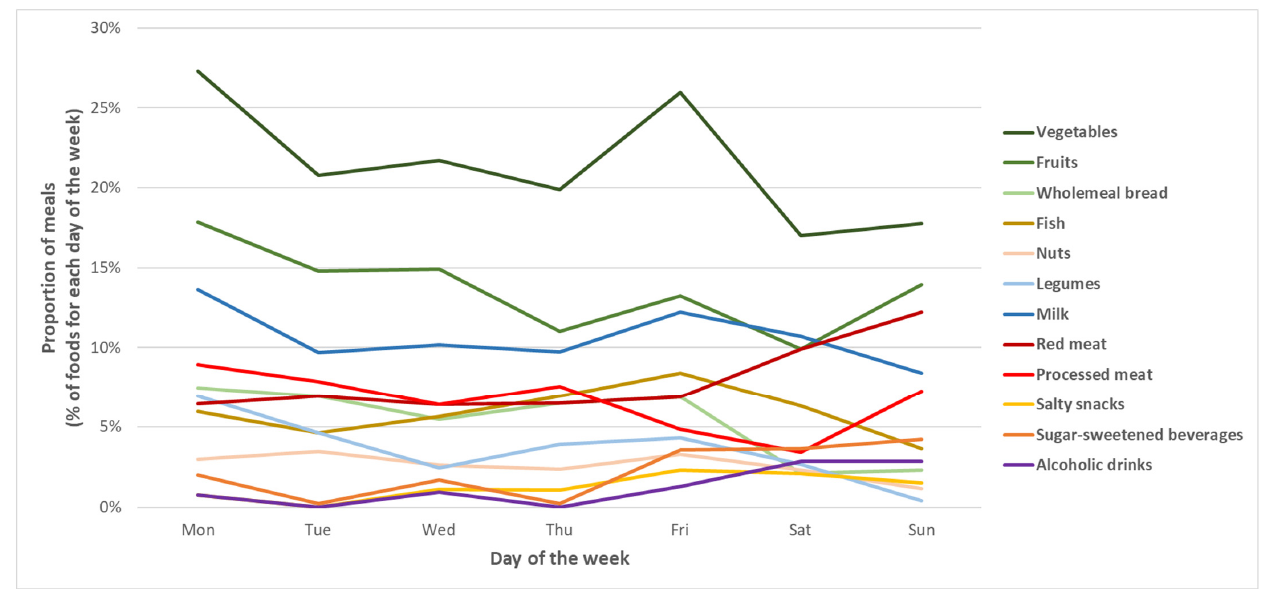
Figure 3. Proportions of meals over the week, stratified for specific foods. Lines represent trends of the percentages of meals occurring over the week for specific food categories. For each day of the week, proportions are obtained by dividing the number of meals including specific foods by the total number of